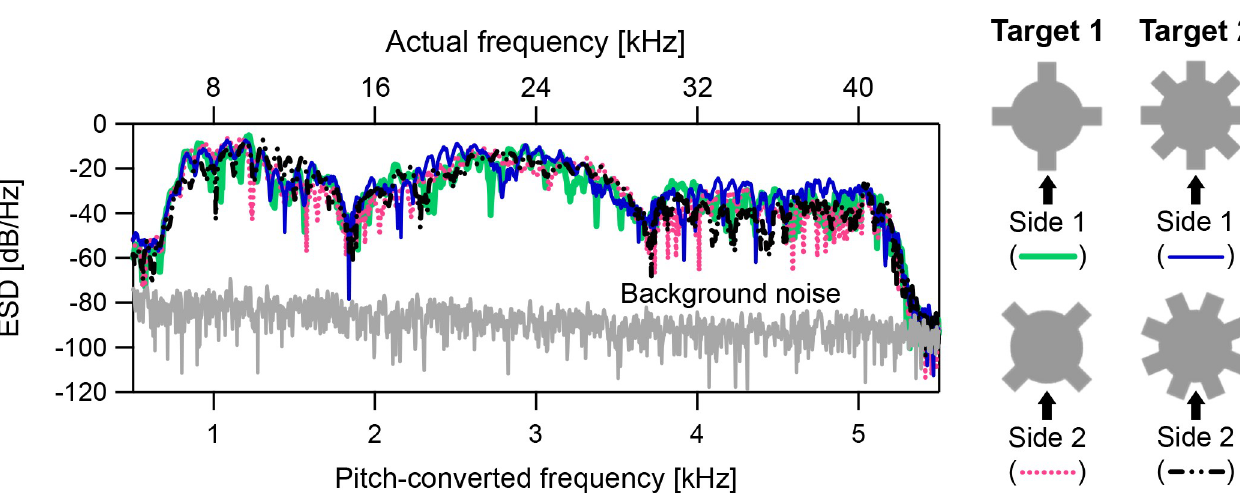
Fig 7. Acoustic similarities among the pitch-converted binaural echoes from stationary targets. This figure provides examples of the energy spectral densities (ESDs) of the pitch-converted binaural sounds to which P12 listened in the training trials under the stationary condition. The pitch-converted binaural sounds include the pitch-converted binaural echoes from side 1 of target 1 (light green bold line), side 2 of target 1 (magenta dashed line), side 1 of target 2 (blue line), and side 2 of target 2 (black two-dot chain line). The gray line denotes the background noise floor. Each ESD was calculated by fast Fourier transform (FFT) after averaging 324 readings of the pitch-converted binaural sounds (using the second to the last pitch-converted binaural sounds). The background noise floor was also calculated by FFT after averaging 324 readings of the sounds. The sampling frequency was 12 kHz, and the length of the FFT window was 4,096 points. The top horizontal axis indicates the actual frequency before pitch